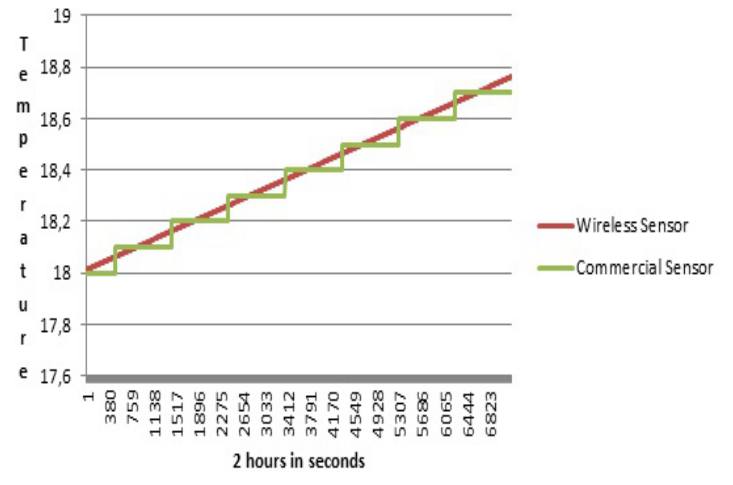
Figure 13. Comparison of temperature measurement devices for 2 hours on the 2nd day.